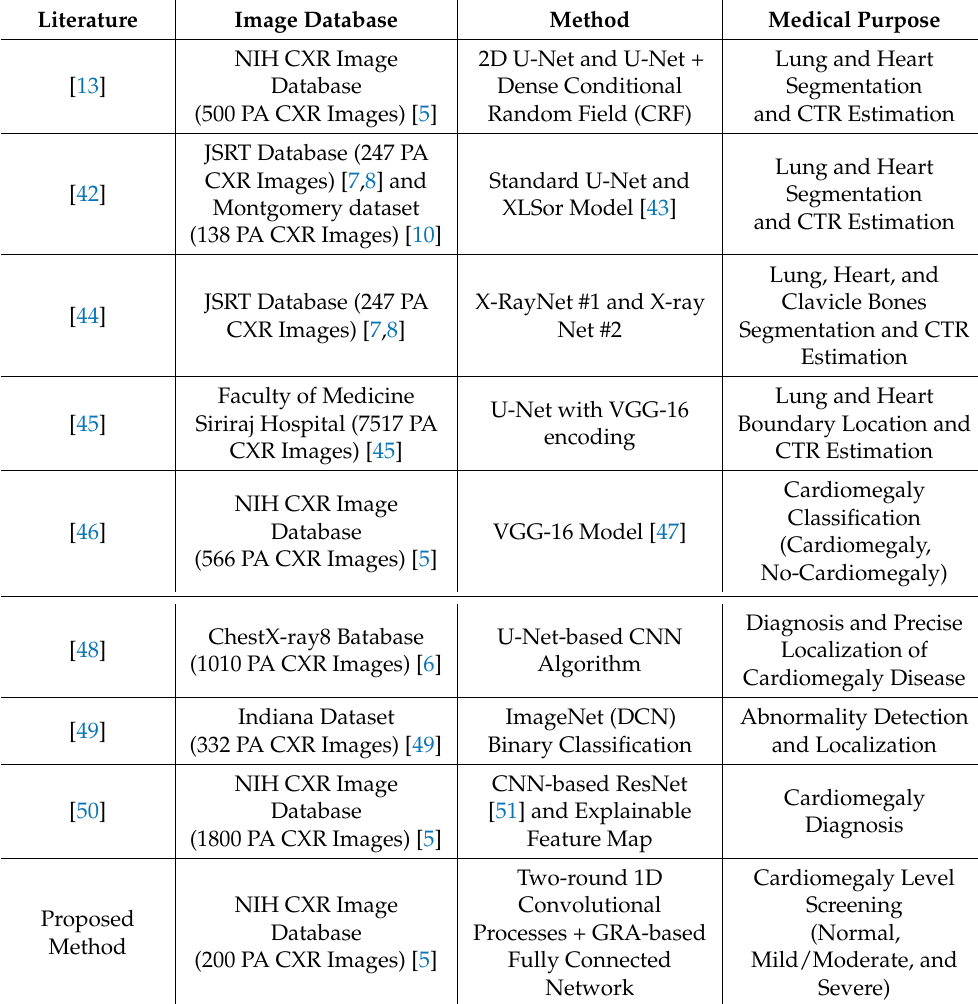
Table 4. Comparison of the cardiomegaly level screening